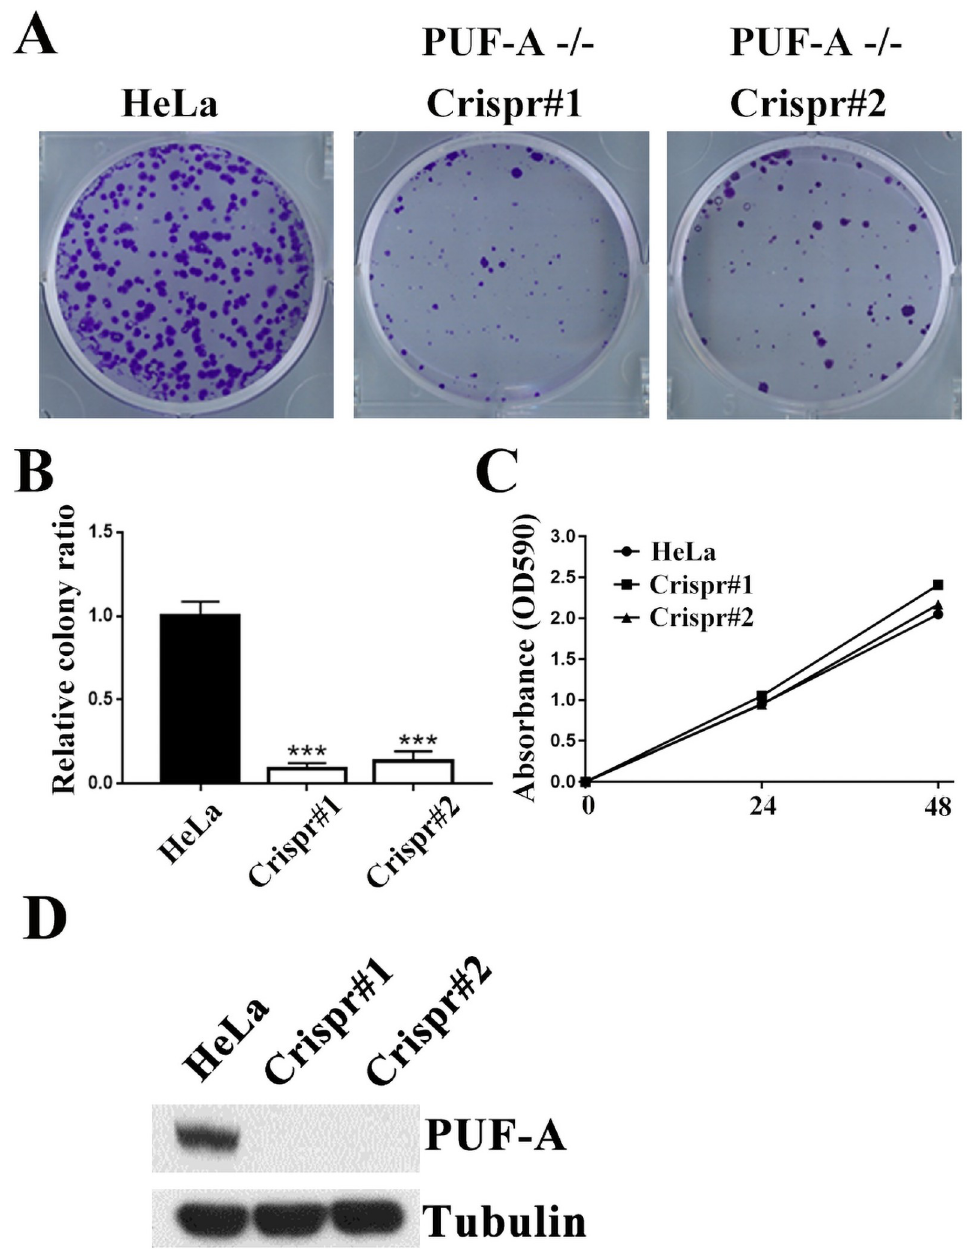
Fig 2. Clonogenic assays in PUF-A-ablated HeLa cells. (A) 800 cells were plated on 6-well dishes and grown for 10–14 days. Cells were stained with crystal violet. Colonies larger than 0.1 mm in diameter were scored. (B) Quantitative results are shown and each bar represents the mean ± SD of three independent experiments. ��� P < 0.001. (C) Cell proliferation was determined by MTT assay. (D) Cell extracts isolated from control and PUF-A-depleted HeLa cells were immunoblotted with the indicated antibodies. All Western blots were processed in identical conditions and cropped from S4 Fig. orthovanadate (S1A Fig), indicating that protein dephosphorylation was important for PUF-A’s translocation to the nucleoplasm. Meanwhile, HA-PUF-A transfected HeLa cells were exposed to 5,6-dichlorobenzimidazole riboside (DRB, an inhibitor of RNA polymerase II) or CPT for subsequent immunoprecipitation and immunoblot analyses. The results showed